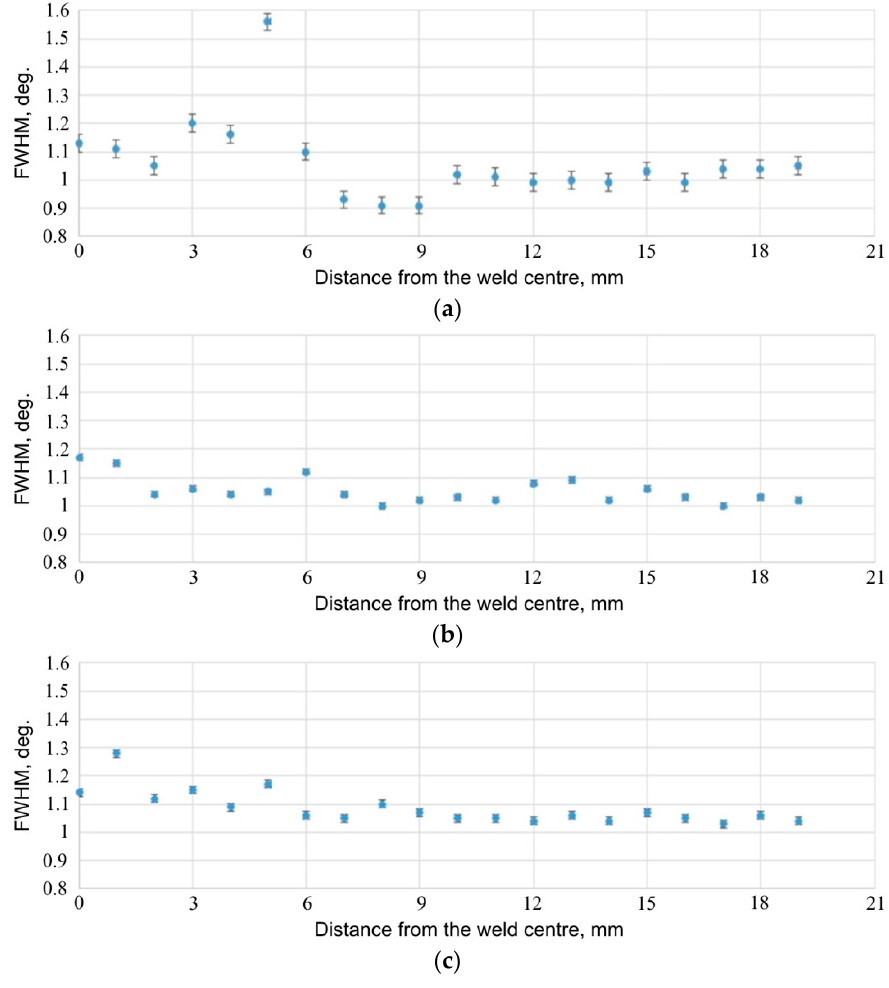
Figure 29. FWHM of diffraction peaks obtained from ( a ) 1.6 mm sheet of E5 specimen, ( b ) 0.8 mm sheet of E5 specimen and ( c ) 1.6 mm sheet of E6 specimen.